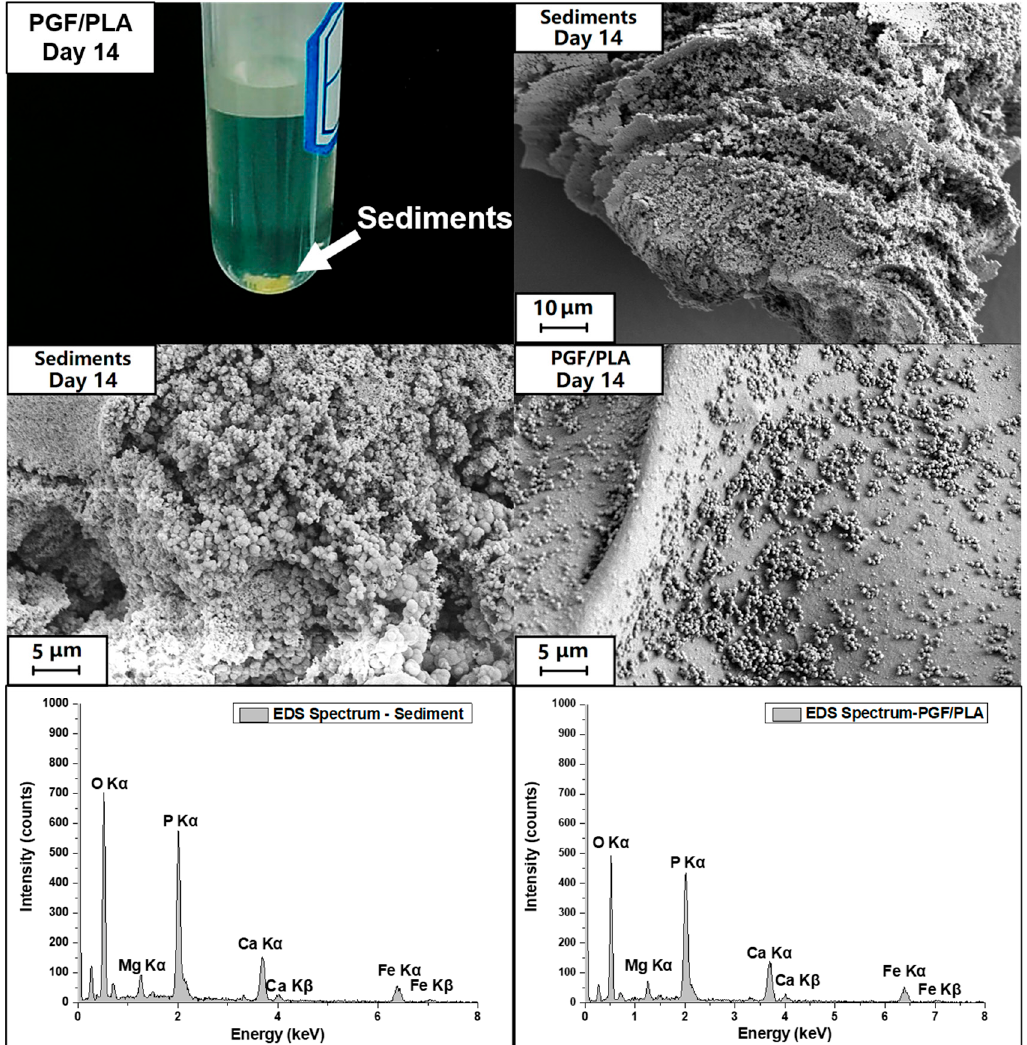
Figure 8. Photograph showing the yellow sediments in the degradation media immersed with PGF/PLA for 14 days, and the SEM images as well as the Energy-dispersive X-ray Spectroscopy (EDS) spectra of both the sediments and the top surfaces of PGF/PLA composite scaffolds.